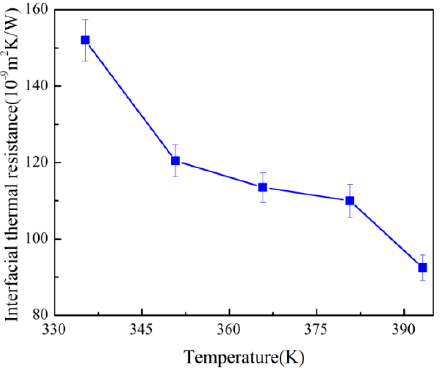
Figure 3. Variations of the interface thermal resistance (ITR) with different temperatures.